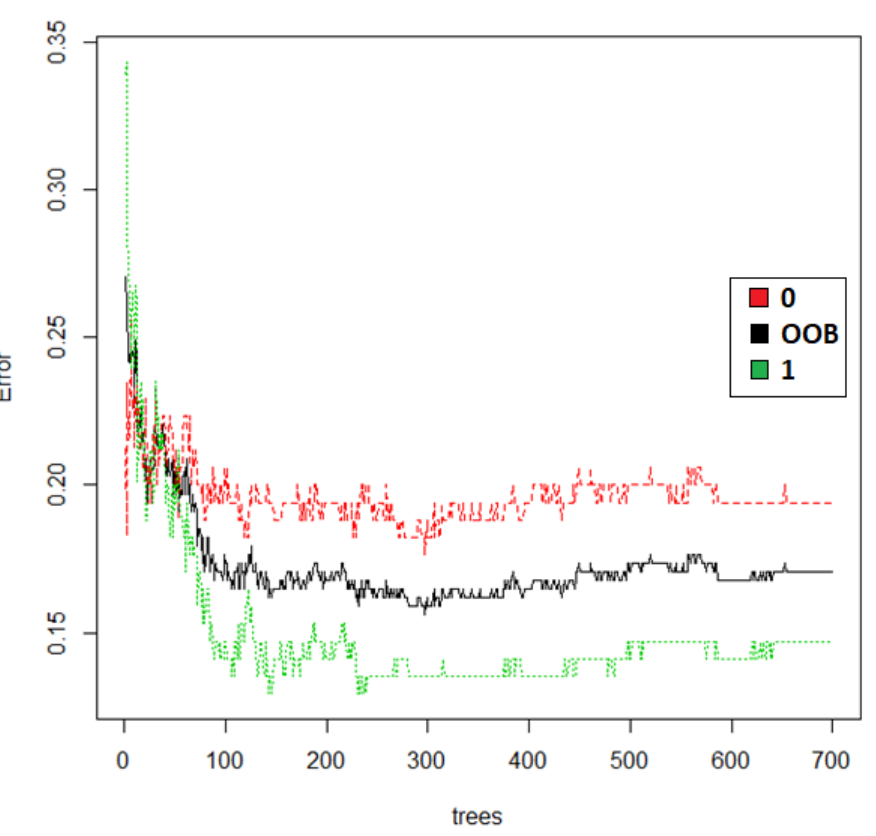
Figure 6. Misclassification / error rate as a function of trees grown in RF.